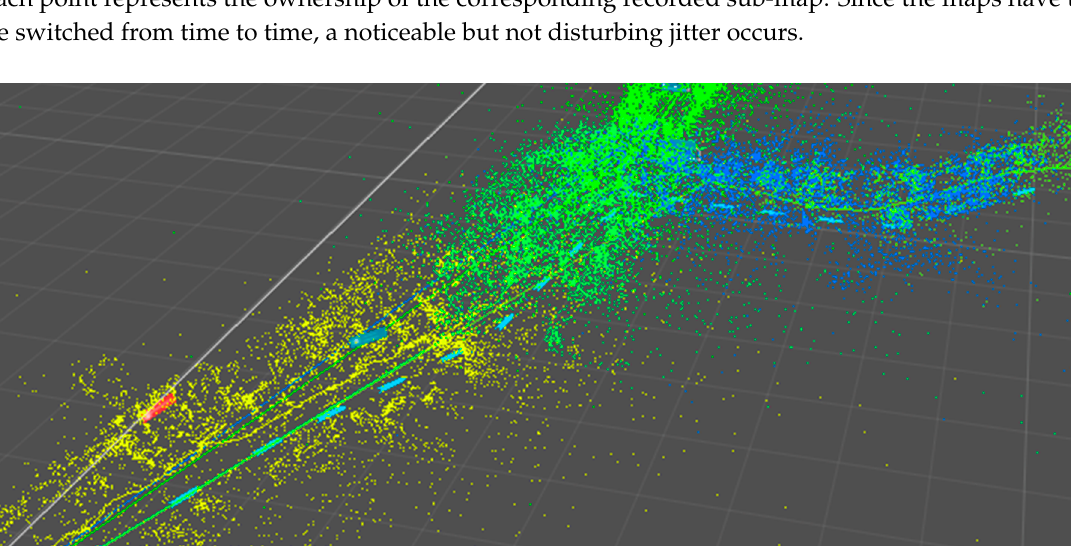
Figure 11. Point cloud of the mapped area on the airport. Lines show the distance traveled. Red (stop sign) and blue (path) rectangles are the AR content visualized for the user during a tracking session.